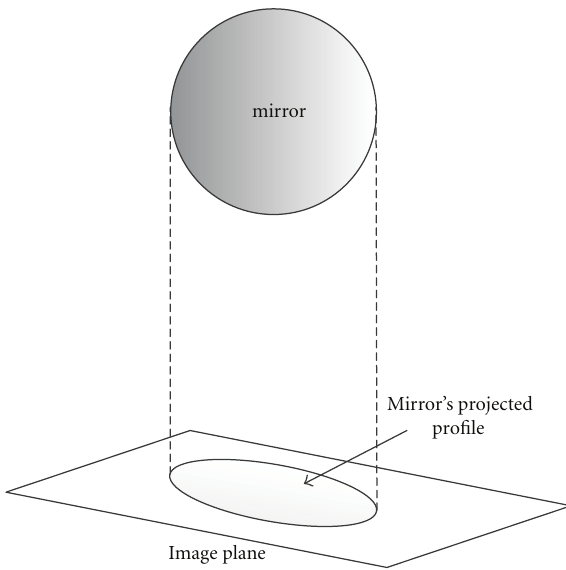
Figure 4: Mirror’s profile projected over image plane.